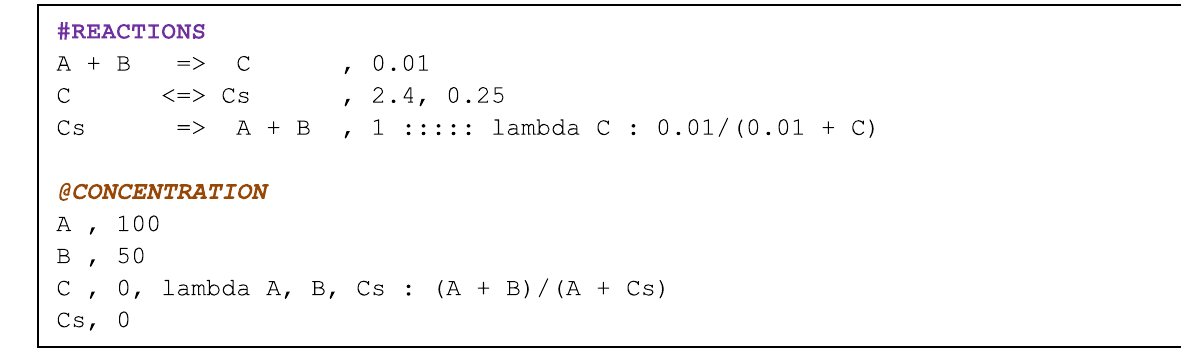
Fig 2. An example of a topology file that can be used to perform simulations in